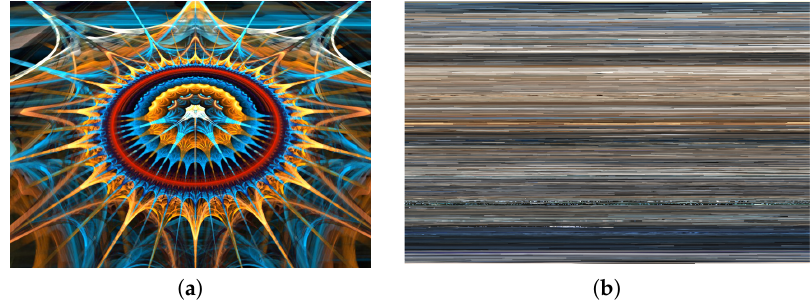
Figure 5. Procedural artworks in the fine art world of galleries and art museums. ( a ) Electric Sheep , by Scott Draves, evolves dazzling procedural abstract animations based on thousands of votes. Creative Commons (CC-BY-3.0 US) image, “sheep” by BrothaLewis. ( b ) The Top Grossing Film of All Time , 1 × 1 (2000) by Jason Salavon, shows the average color of each frame of the movie Titanic. Used by permission of the